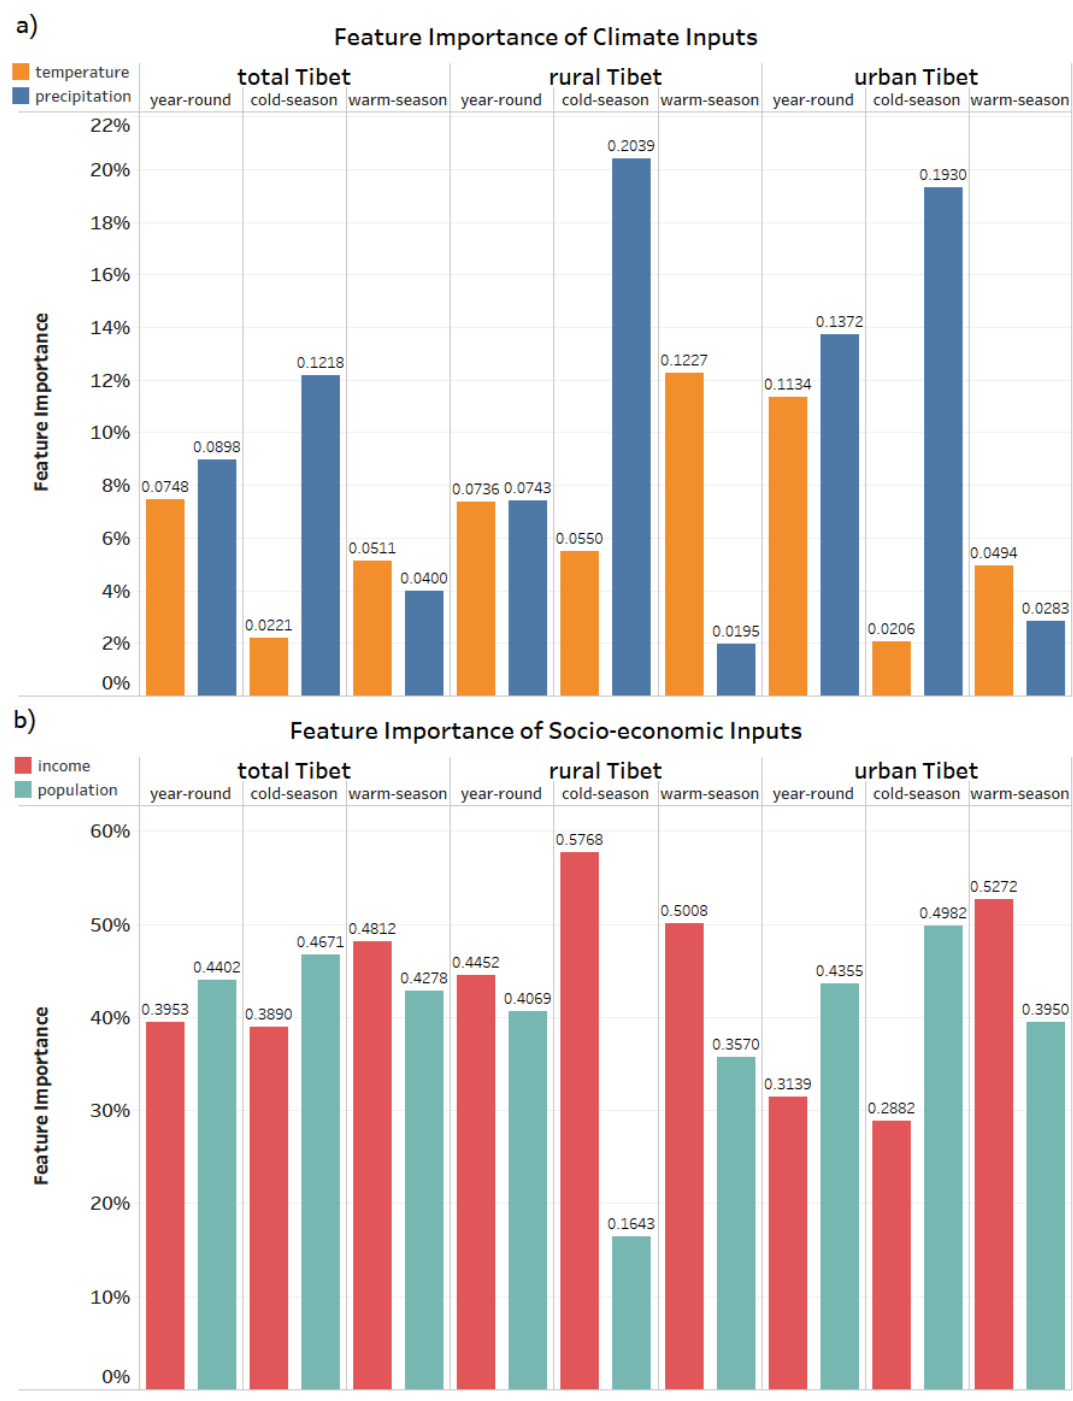
Figure 4. Feature importance score (FIS) results of tree-based models estimating Tibet REC at different scales. Plots ( a , b ) show the FIS results of climate and socio-economic inputs, respectively. The FIS was standardized and can be compared across models.